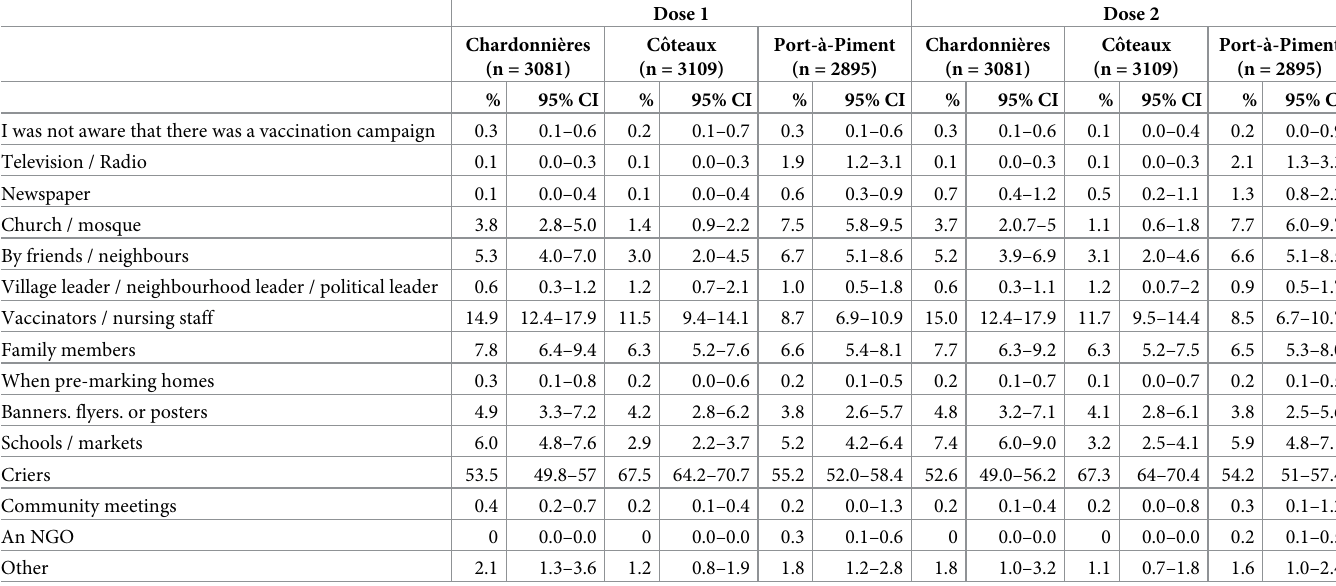
ing dose two respectively. Among those who reported adverse events, the most common were Table 1. Source of information about the vaccination campaign by dose and Commune, South Department, Haiti,